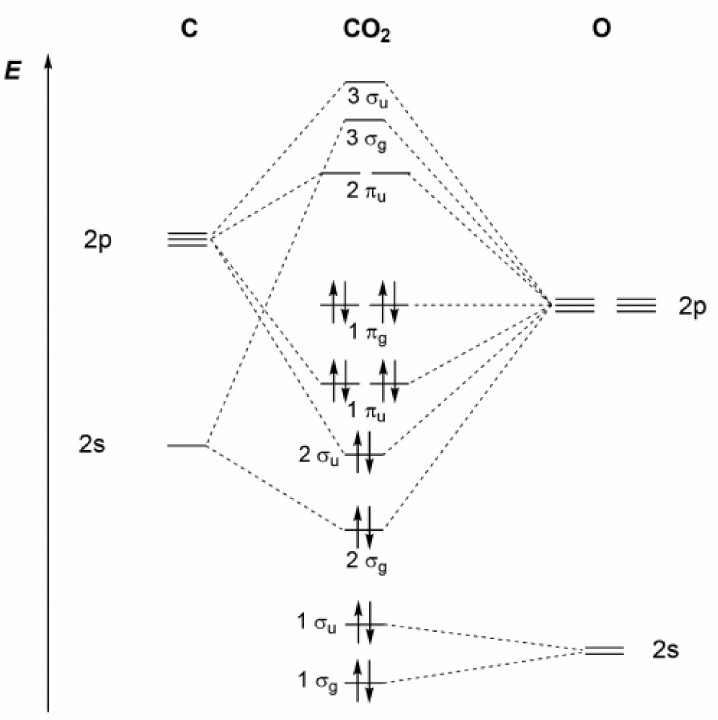
Figure 14. Qualitative molecular orbital diagram of carbon [16,120,121]. Reprinted with permission from [16]. Copyright 2018, American Chemical